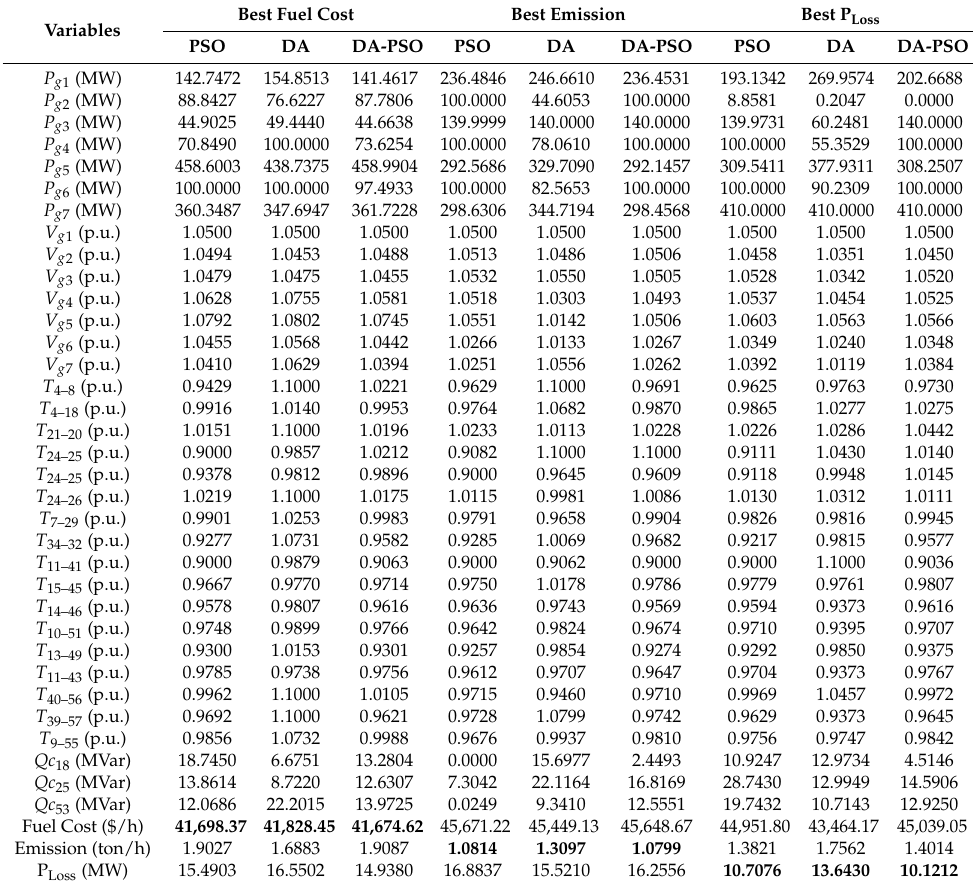
Table 5. Comparison of the simulation results from PSO, DA, and DA-PSO for IEEE 57-bus system. Best Fuel Cost Best Emission Best P Variables